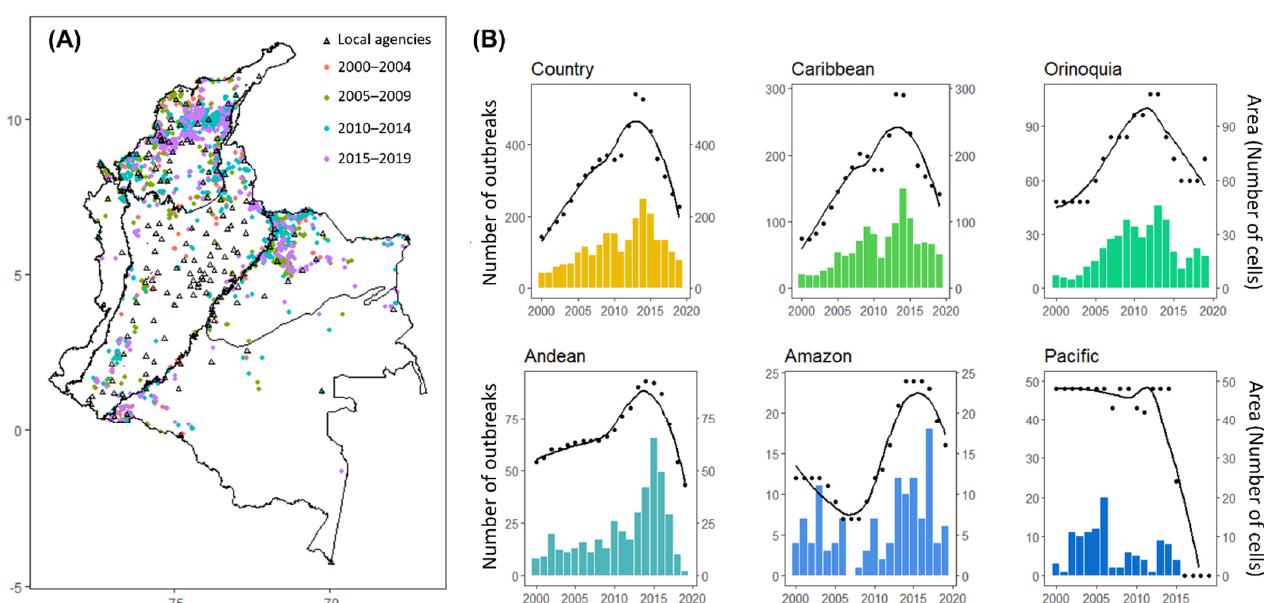
Figure 1. Spatial and temporal distribution of VBR outbreaks in Colombia from 2000 to 2019: ( A ) Locations of VBR outbreaks across the five biogeographic regions of Colombia. Point colors illustrate the five-year periods of outbreak occurrence. Triangles represent the local reporting offices of the ICA’s national rabies surveillance system; ( B ) Bars represent the total number of VBR outbreaks per year. Points correspond to the estimated annual infected area, expressed in number of cells. The number of cells was estimated as the sum of cell grids with a density level higher than the 95th percentile value (i.e., density = 0.01) from a Kernel estimation choosing a bandwidth = 0.01 and a grid = 200 × 200 cells. Lines (black) represent the model prediction tendency estimated using the method ‘loess’ in the geom_smooth function of the ggplot2 in R. Each plot represents estimates at the country or biogeographic region level.